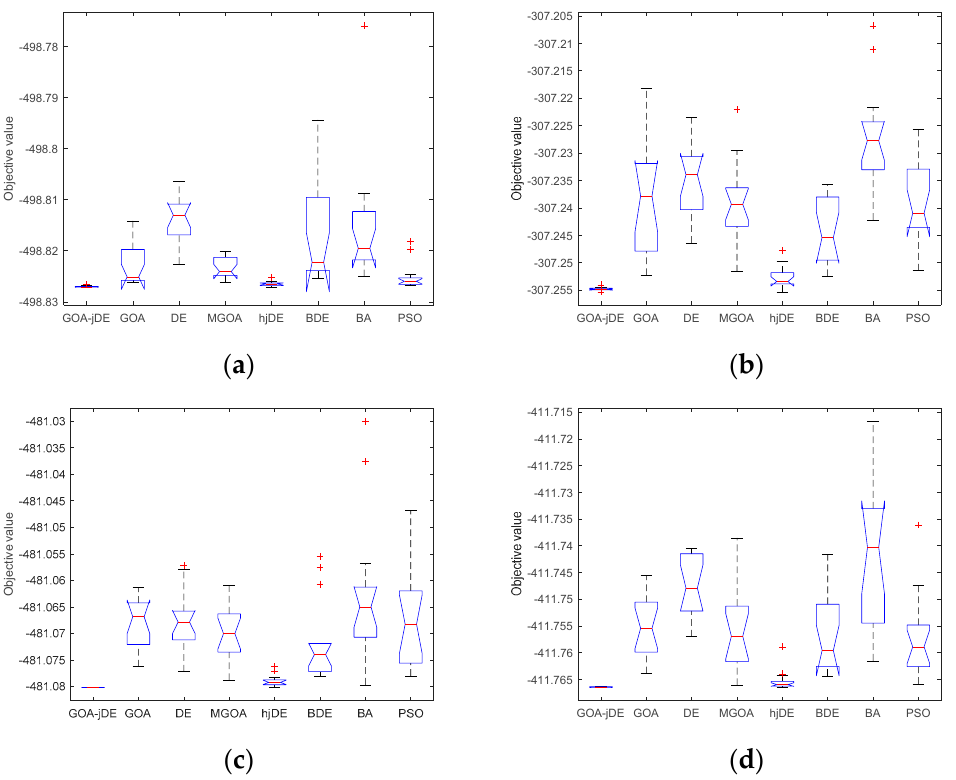
Figure 11. The boxplot for fitness function using MCE method at 12 threshold levels. ( a ) Image5, ( b ) Image6, ( c ) Image7, ( d ) Image8.